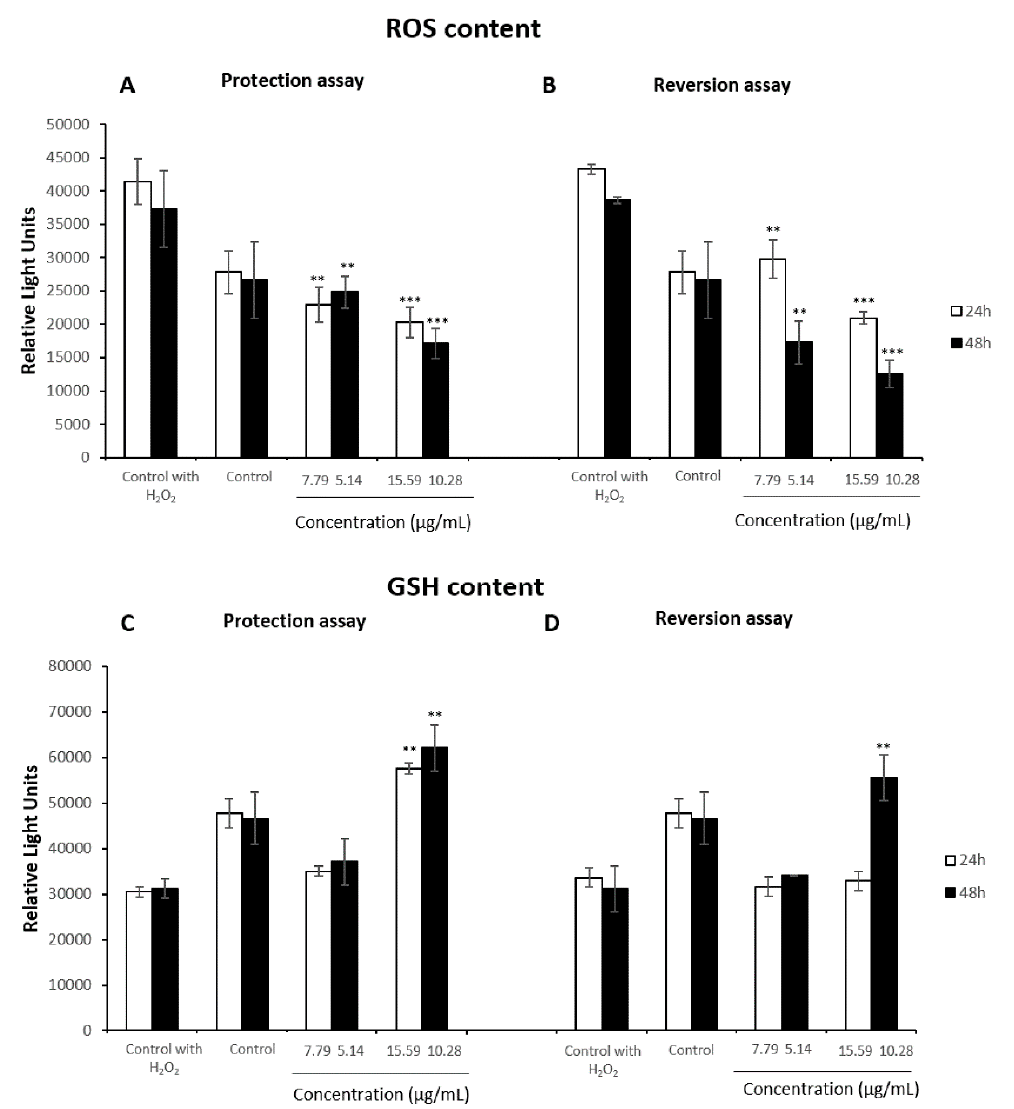
Figure 7. ROS ( A ) and GSH content ( C ) in HepG2 cells first pretreated with 0–15.59 µ g / mL or with 0–10.28 µ g / mL of the stilbene extract (45%) for 24 h or 48 h, respectively, and a later exposure to H 2 O 2 100 µ M for 2 h. ROS ( B ) and GSH ( D ) content in HepG2 cells exposed to H 2 O 2 100 µ M first and a later 24 h or 48 h-treatment with 0–15.59 µ g / mL or 0–10.28 µ g / mL, respectively. Cells exposed to H 2 O 2 100 µ M 2h were used as control. All values are expressed as mean ± SD. Di ff erences were considered significant compared to the control group from p < 0.01 (**) and p < 0.001 (***).